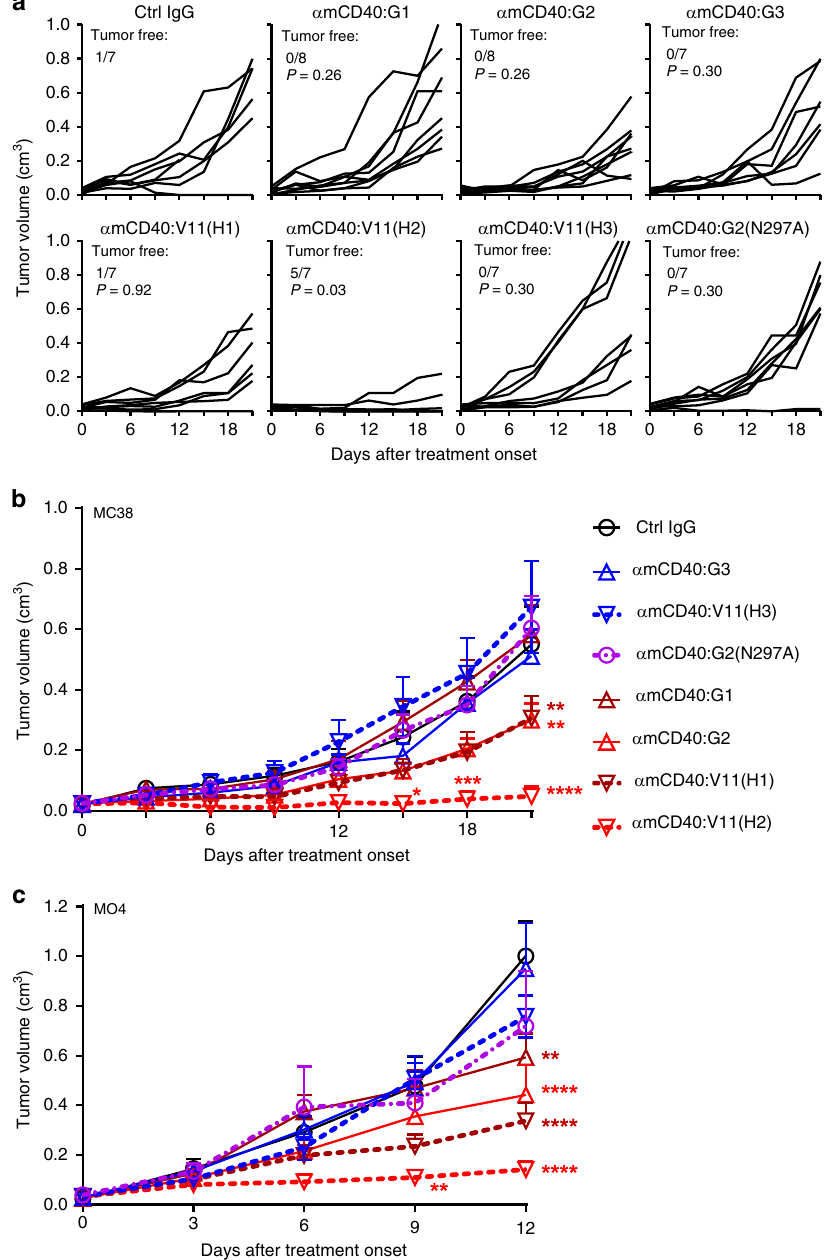
Fig. 3 Impact of both IgG CH1-hinge and Fc on anti-CD40 antibody antitumour activities. MC38 ( a , b ) and MO4 ( c ) tumour volumes in Fc γ R-humanized mice following treatment with control or anti-mCD40 antibodies of indicated constant domains. After tumour cells were subcutaneously inoculated and established in Fc γ R-humanized mice, mice were treated i.p. twice on day 0 (the day when mice with palpable tumours receive their fi rst treatment) and day 3 with 31.6 μ g/ mouse of control or anti-CD40 antibodies of indicated constant domains (the N297A mutation abrogates Fc – Fc γ R binding), and monitored for tumour growth. For mice inoculated with MO4 tumour cells in ( c ), each treatment also included 2 μ g/mouse of DEC-OVA. Shown are tumour growth curves of individual mice ( a ) or mouse groups ( b , c ). Numbers of mice: a , b seven to eight mice per group; c seven mice per group except six mice for α mCD40:G2(N297A). Bars represent the mean±SEM. * p ≤ 0.05, ** p ≤ 0.01, *** p ≤ 0.001, **** p ≤ 0.0001, chi-square test ( a ), and two-way ANOVA with Holm – Sidak ’ s post hoc ( b , c ) were used for group comparison. Source data ( a – c ) are provided as a Source Data fi le. A representative of two independent experiments is shown ( a , b